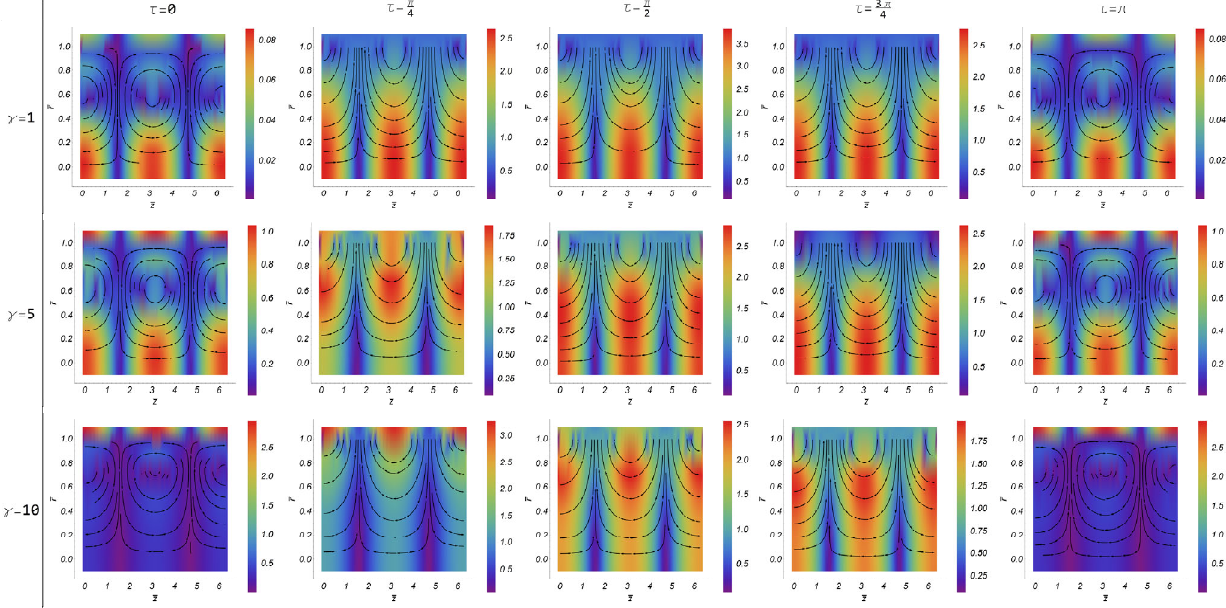
Figure 2. Velocity stream density plots and velocity magnitude contours (colored) along 𝑧̄ and 𝑟̄ axes, for ε = 1, for three values of the Womersley number ( γ = 1, 5, 10), at five instances within half a period ( τ = 0, π /4, π /2, 3 π /4, π ).